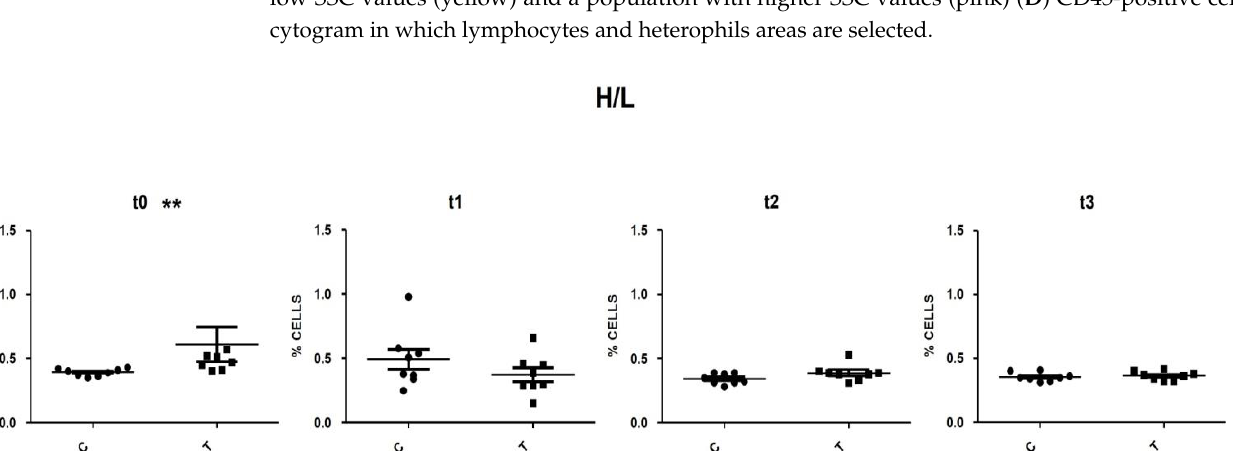
Figure 4. Scatter plot of H/L ratio in C and T group at t0, t1, t2 and t3. **: statistically significant ( p < 0.01). T = supplemented hens ( n = 60); C = control hens ( n = 60); H/L = heterophils/ lymphocytes ratio; t0 = start of the trial; t1 = after 5 weeks of supplementation; t2 = end of supplementation; t3 = end of the trial.